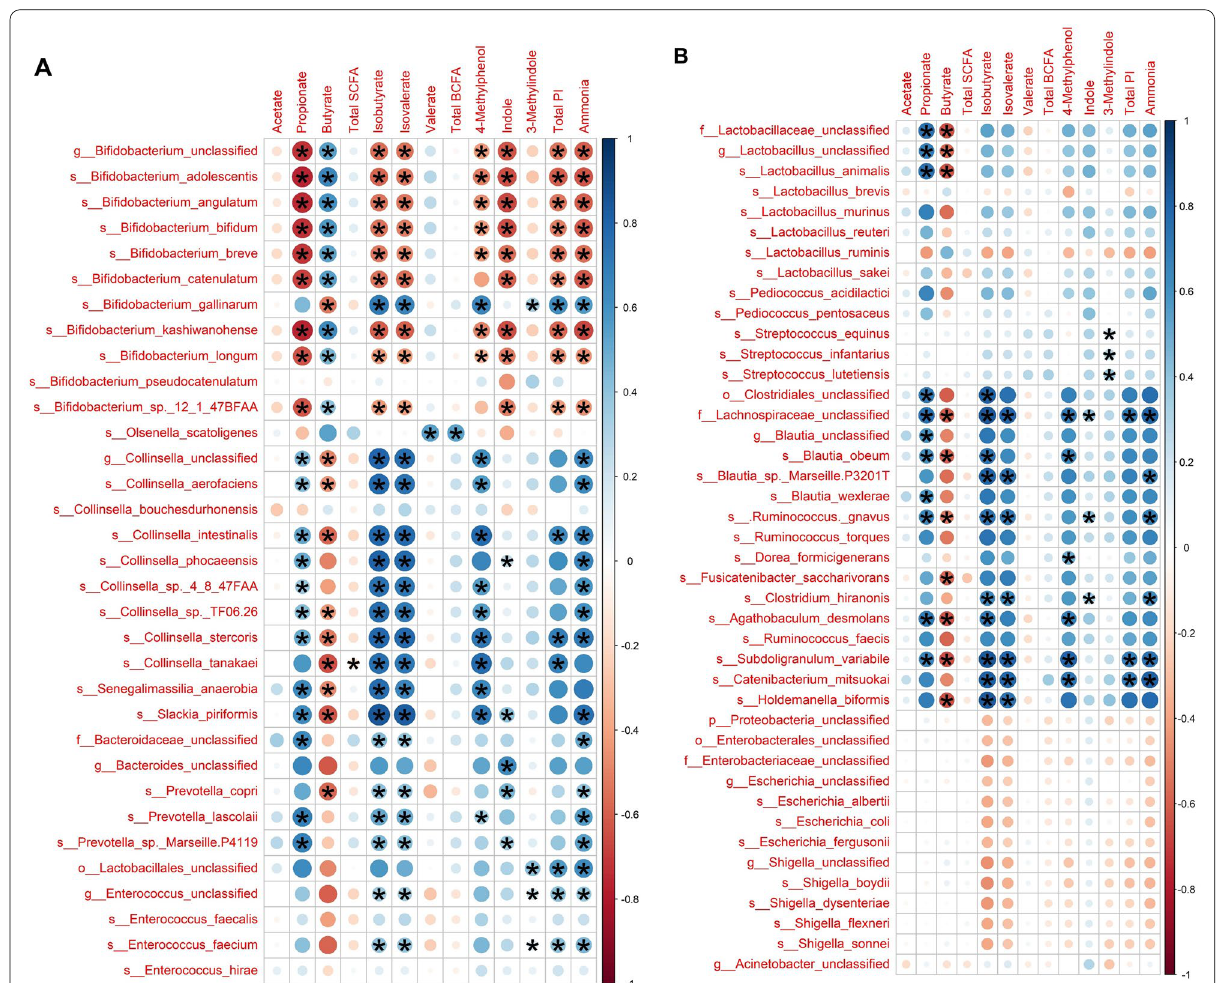
Fig. 6 Correlation plots between fecal microbial species and fecal metabolites of cats fed the experimental diets. The X and Y axes are the metabolites and species, respectively. R values are represented by different colors (blue: positive; red: negative). Significant correlations ( P adj < 0.05) are indicated by